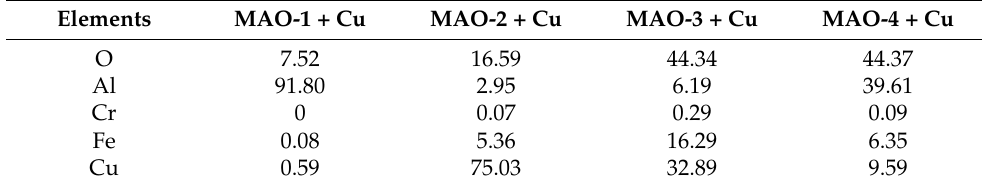
Figure 5. Surface morphologies and EDS results of composite coatings after friction tests: ( a ) MAO-1 + Cu; ( b ) MAO-2 + Cu; ( c ) MAO-3 + Cu; ( d ) MAO-4 + Cu. Table 4. EDS analysis of MAO + Cu composite coatings after abrasion test (at.%).